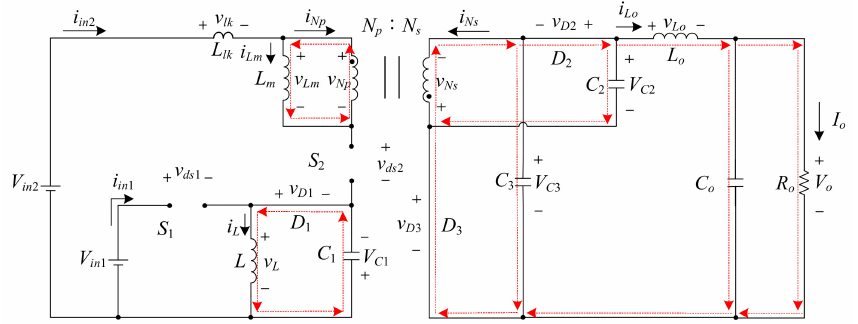
Figure 10. State 4 power